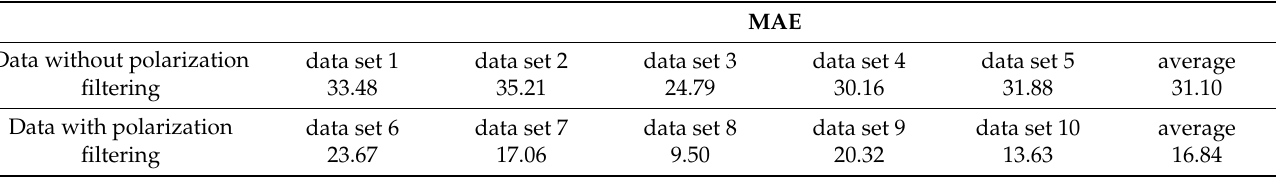
Figure 11. Tool-wear-estimation results: ( a ) data without polarization filtering; ( b ) data with polar- ization filtering. Table 2. Evaluation of experimental results.